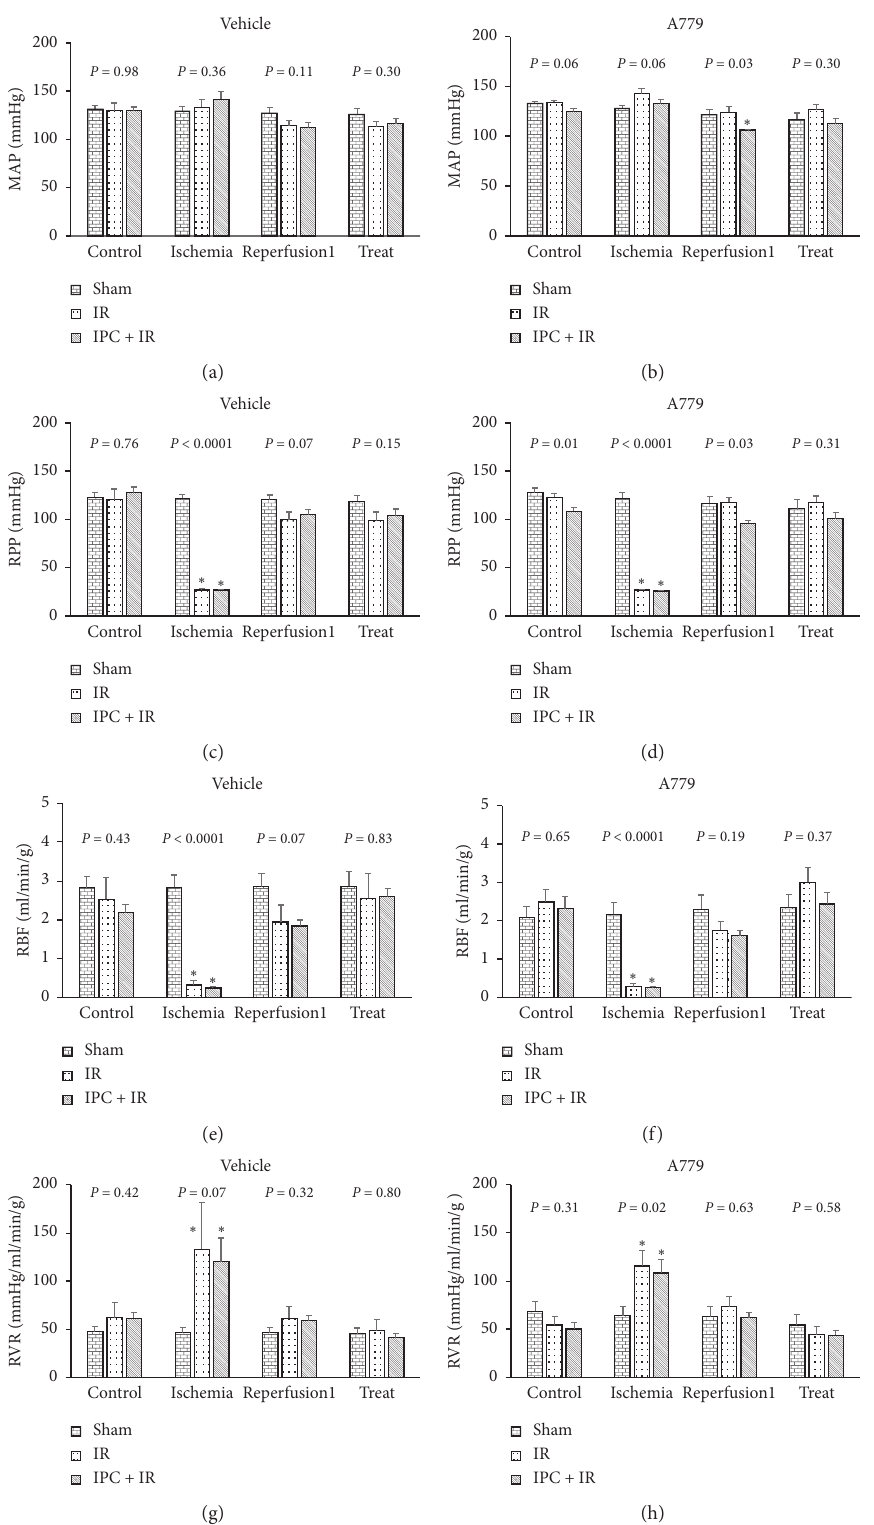
Figure 1: The hemodynamic parameters before Ang II administration in sham, IR, and IPC +IR groups in control, ischemia, 1–3 min postreperfusion (reperfusion1), and 30min after antagonist/vehicle infusion (treat) phases. Data are presented as mean ± SEM. The P values were derived from one-way ANOVA. MAP: mean arterial pressure, RPP: renal perfusion pressure, RBF: renal blood flow, RVR: renal vascular resistance. ∗ Significant difference from the sham group ( P <